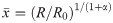
Time course of the SARS-CoV-2 epidemic in Germany (symbols) compared to solutions of the heterogeneous SIR model (lines).(a) and (b) Data on daily reported infections (red) and on reported infections with later fatal outcome (blue) as logarithmic and linear plots. (c) and (d) same data and model solutions as in (a) and (b) but for cumulative numbers of cases. The horizontal dashed lines indicate scaled herd immunity levels. Parameter values for the model solution are R0 = 2.67 (R0 = 3.91), γ = 0.146 (γ = 0.069), α = 0.05 and N = 8107 for the fatal cases (for all cases). The case fatality rate that corresponds to this solution is f = 0.13% (f = 0.11%). (e) Time courses of the fraction of infected I/N (blue), the new cases per day J/N (red) and the fraction of cumulative cases C/N (yellow) for R0 = 2.67 and γ = 0.146. (f) Time course of the average susceptibility x¯=(R/R0)1/(1+α) (blue), where R is the time dependent reproduction number and of τ=α(1/x¯-1) (red) for the solution shown in (e). Inset: distributions of susceptibility in the population for different values of τ.